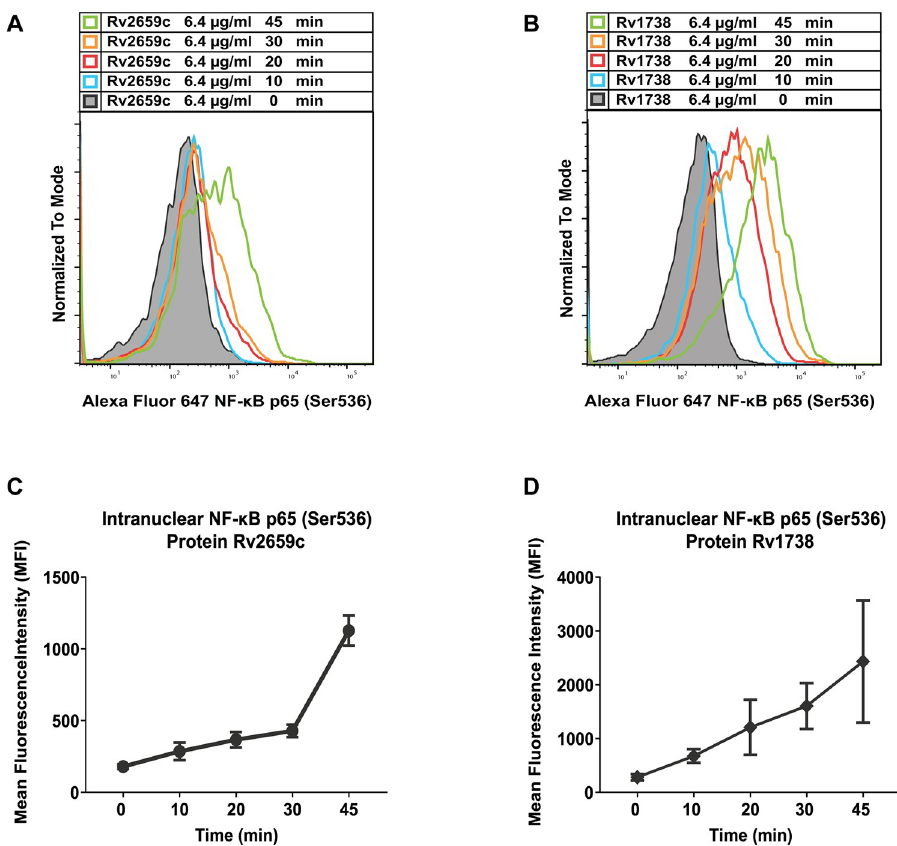
Fig 2. Phosphorylation of NF- κ B p65 (Ser536) in human CD14 + population after treatment with 6.4 μ g/ml of recombinant proteins Rv2659c or Rv1738. Representative flow cytometric histograms showing translocation of NF- κ B p65 (Ser536) in human CD14 + population after treatment of hPBMCs with proteins Rv2659c ( A ) or Rv1738 ( B ). Mean fluorescence intensity (MFI) of phosphorylated NF- κ B p65 (Ser536) from cells treated with proteins Rv2659c ( C ) or Rv1738 ( D ) at each timepoint. Data were acquired by flow cytometry, analyzed by FlowJo software and represented as mean ± SD of triplicate experiments.